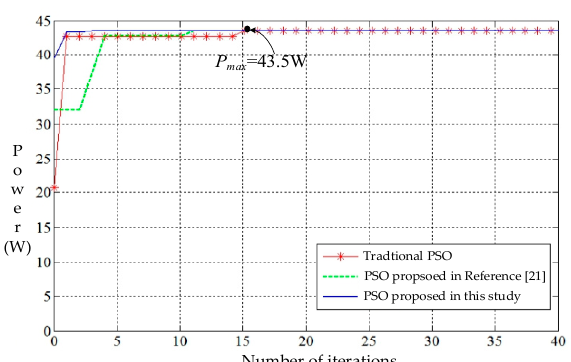
Figure 13. Simulation of P–V characteristic curve in Case 4.